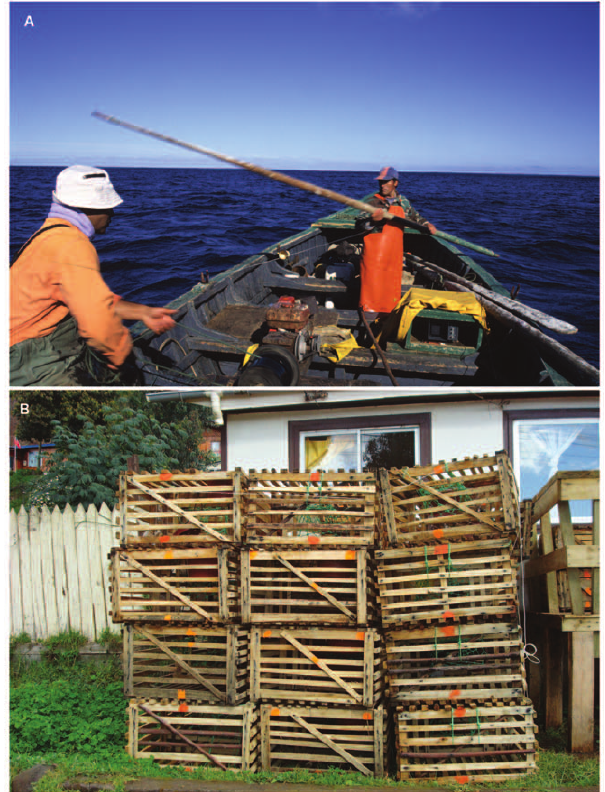
Figure 2. Lobster fishing gear on the Juan Ferna´ndez Archipelago. A - Technology consists of a wooden boat, gas-powered winch, depth finder and outboard engine. Photograph by Alejandro Perez-Matus. B - Wooden lobster traps. Photograph by Fabian Ramı´rez.